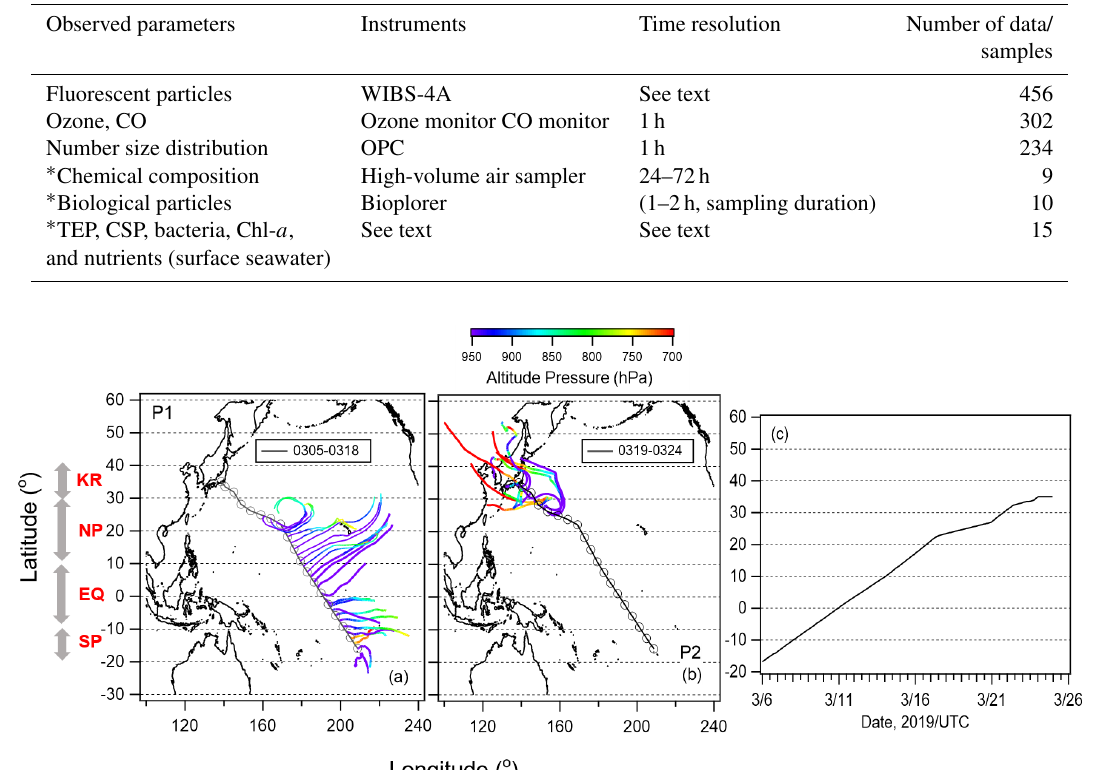
Figure 1. Five-day backward trajectories of air particles along with the cruise track initiated twice a day (06:00 and 18:00UTC) for (a) Period 1 (5–18 March 2019) and (b) Period 2 (19–24 March 2019). Open cycle markers represent the ship position during the observation. Color on trajectories show air parcel altitude. (c) Ship position during study